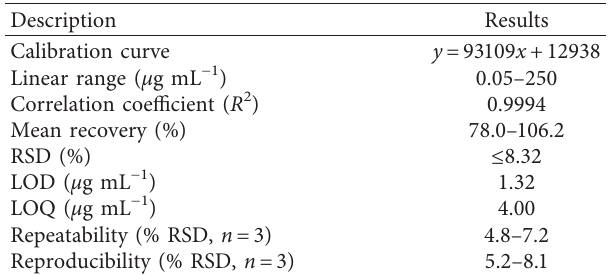
Figure 7: Temperature and time effects on the depletion of Amox concentration. Table 2: Characteristics of the analytical quality assurance for spiked chicken